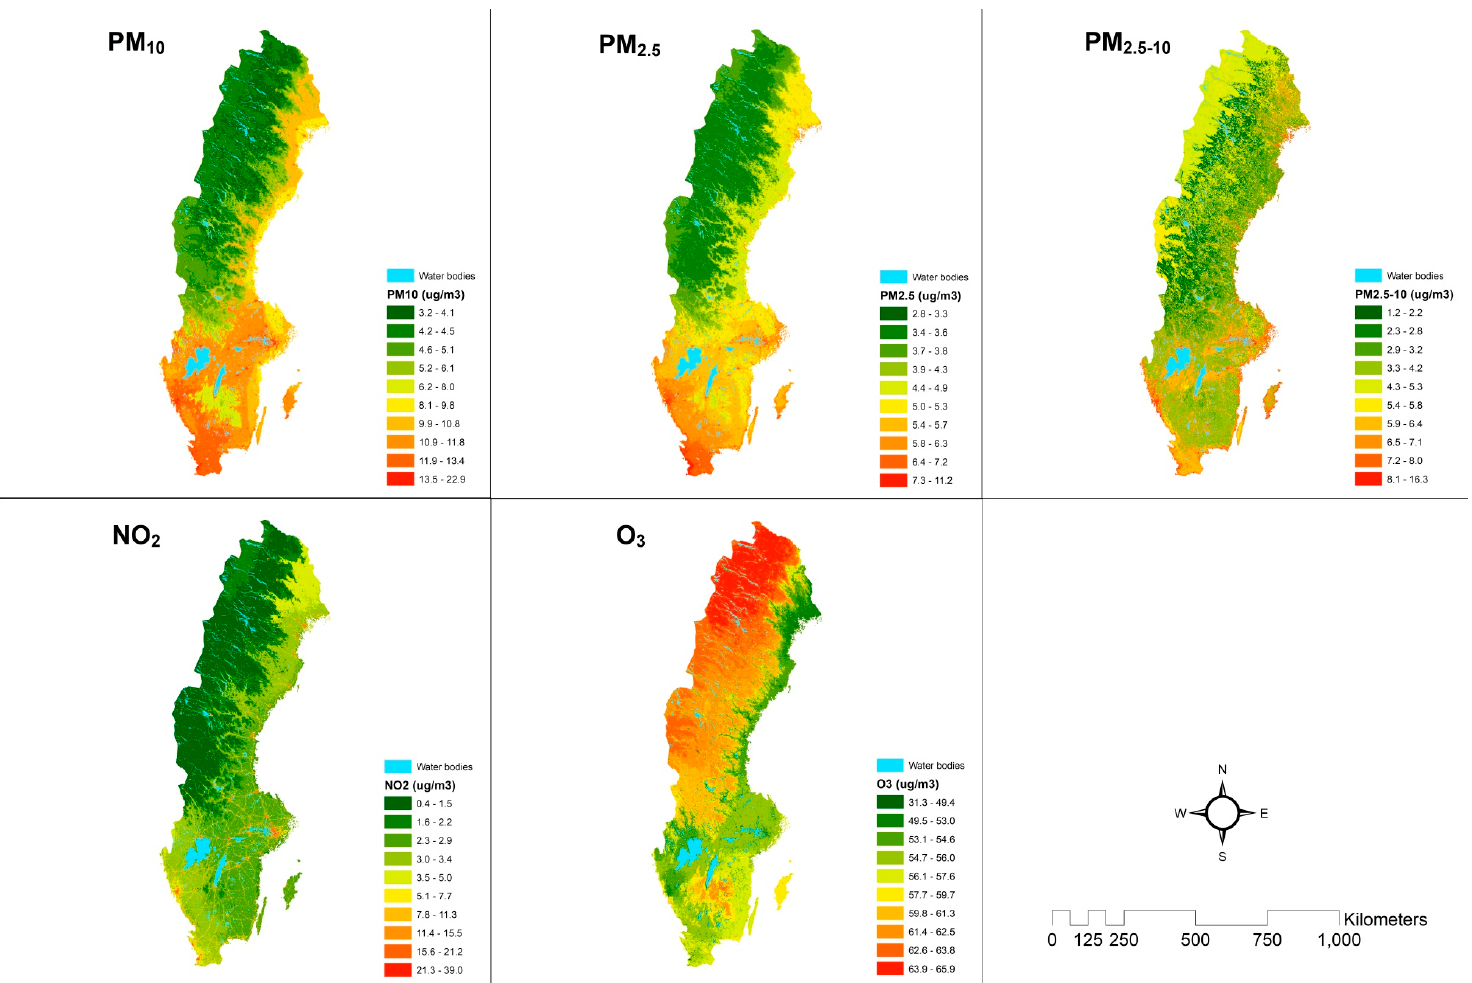
Figure 3. Fields of annual average air pollutant concentrations estimated for year 2016.